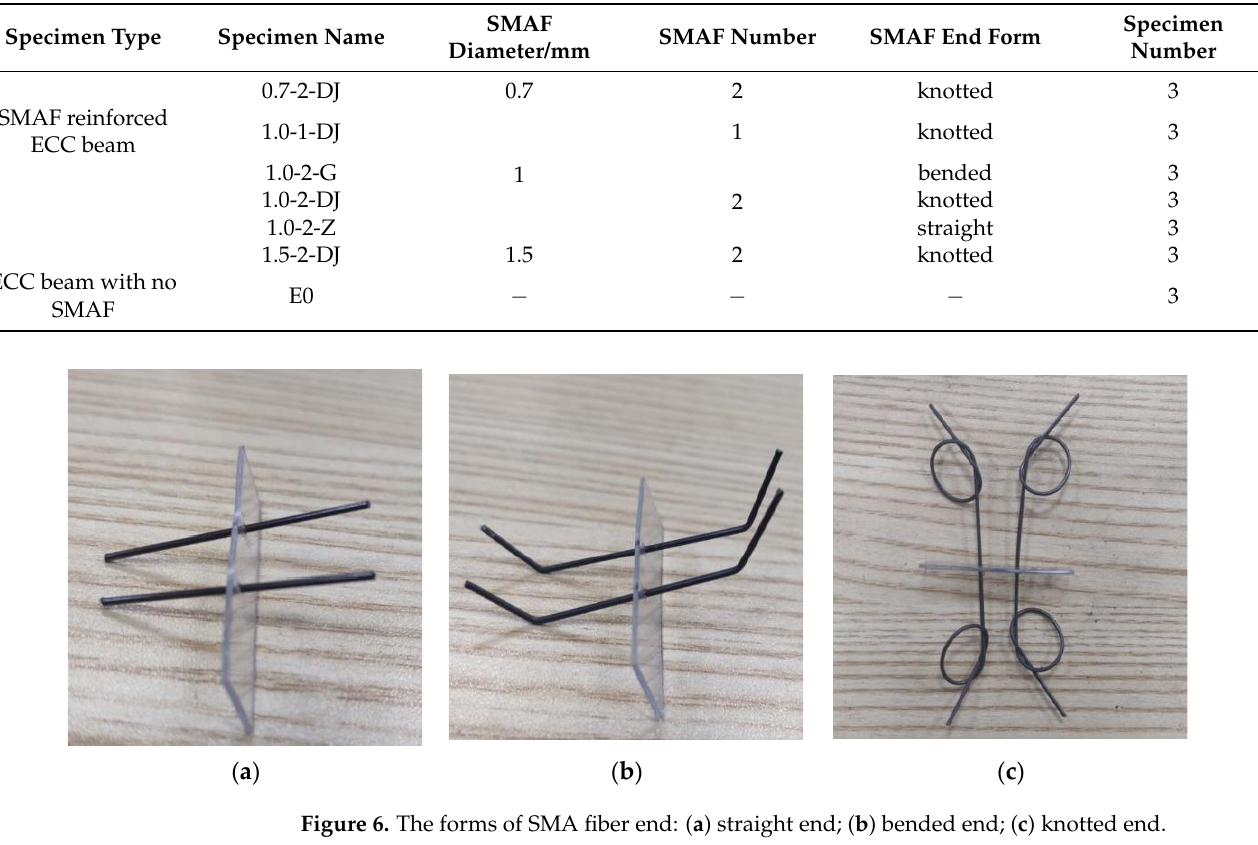
Table 3. T Specimen scheme.